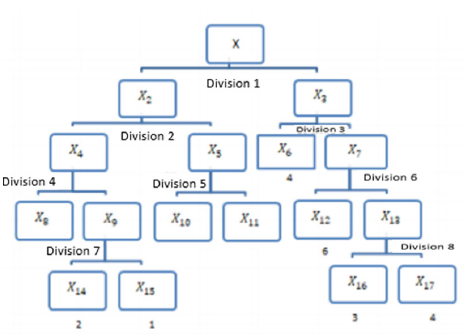
Fig. 1. Structure of the classification tree (Korkmaz et al.